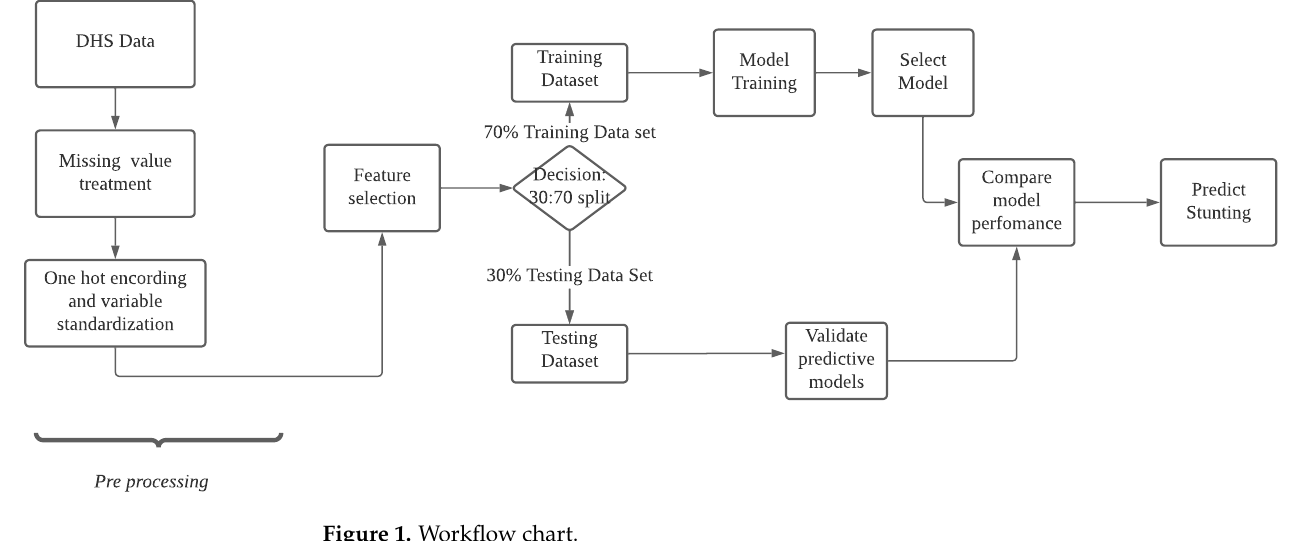
Figure 1. Workflow chart.